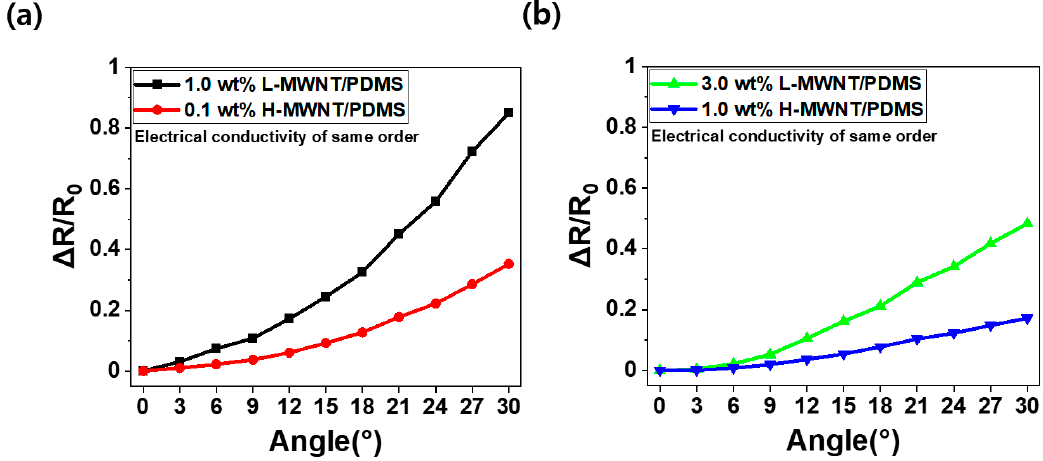
Figure 4. Δ R/R 0 according to bending angle: ( a ) 1.0 wt.% L-MWNT/PDMS (black) and 0.1 wt.% Figure 4. ∆ R / R 0 according to bending angle: ( a ) 1.0 wt.% L-MWNT / PDMS (black) and 0.1 wt.% H-MWNT/PDMS (red). ( b ) 3.0 wt.% L-MWNT/PDMS (green) and 1.0 wt.% H-MWNT/PDMS (blue). H-MWNT / PDMS (red). ( b ) 3.0 wt.% L-MWNT / PDMS (green) and 1.0 wt.% H-MWNT / PDMS